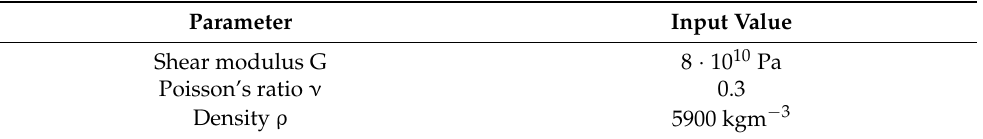
Table 2. Material parameters for the DEM model for the grinding media and milling chamber, both made from